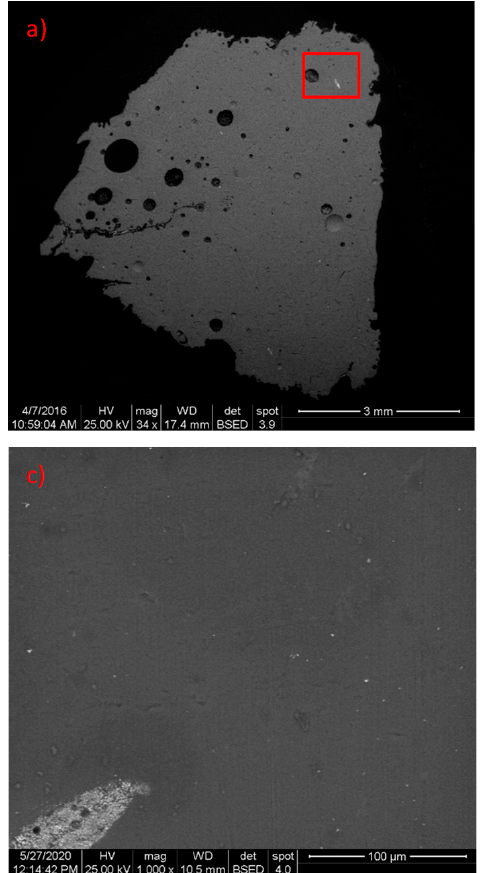
Figure 14. ( a ) BSE image of homogeneous micro-texture of the vitreous matrix, dotted with unevenly distributed micrometric crystals, either alone or in clusters, ( b ) BSE image at 500X, and ( c ) BSE image at 100×, where the distribution of crystal could be better evaluated (DMS_11M green/yellow natron-based tessera, Apollonia-type glass, from the Great Mosque of Damascus, Syria—unpublished data [24,25]).